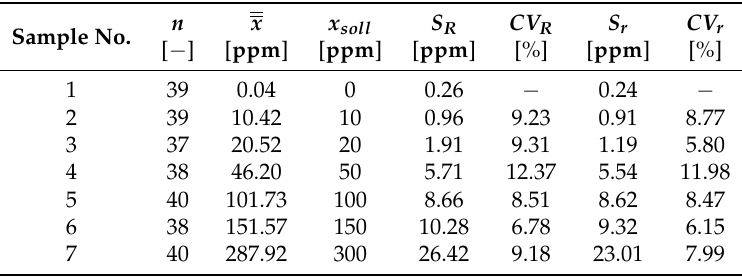
Table 5. Data of inter-laboratory trials from the four OiW monitors based on weighted least square (WLS) calibration. Sample